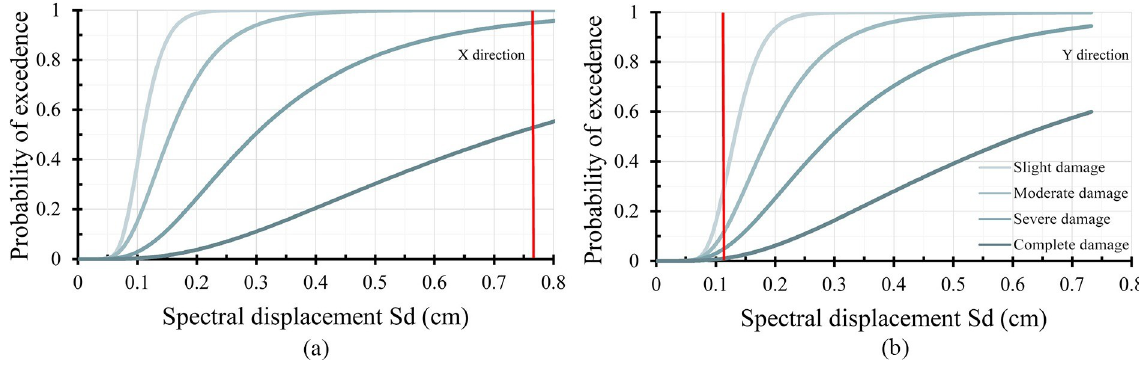
Fig 6. Reference building fragility curves in the X (a) and Y (b) direction, highlighting in red the PP displacement.